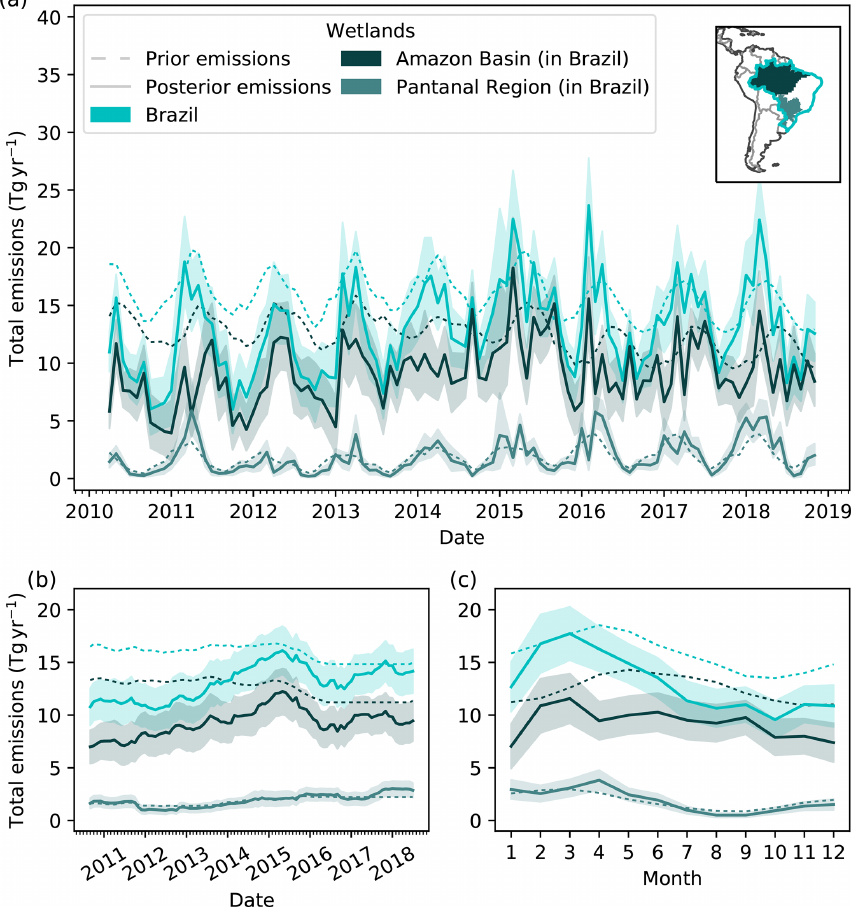
Figure 5. Brazil’s wetland emissions aggregated over Amazon and Pantanal regions. (a) Monthly emissions with an inset map showing the masks used to delineate between the Amazon and Pantanal regions, (b) monthly emissions smoothed with a 12-month rolling mean and (c) seasonal means across the 2010 to 2018 period. Errors for mean values assume a 50% correlation between individual